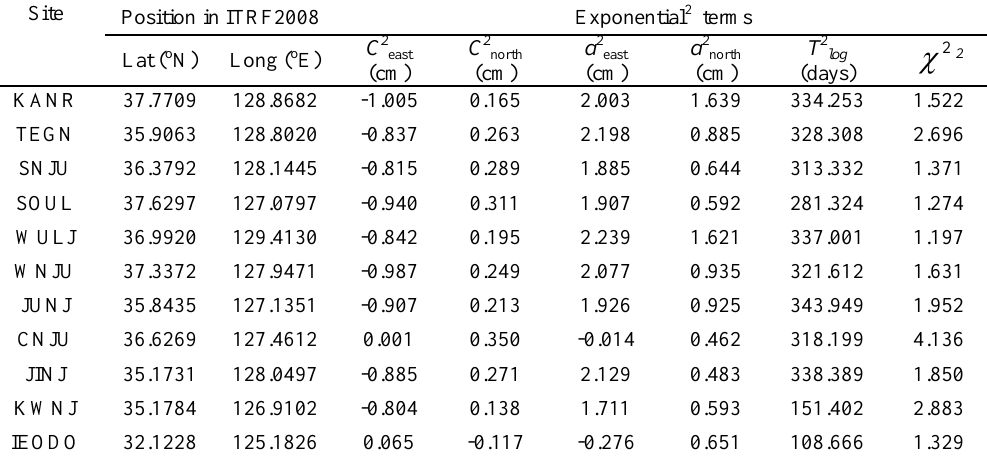
Table 2. Postseismic parameter of exponential decay